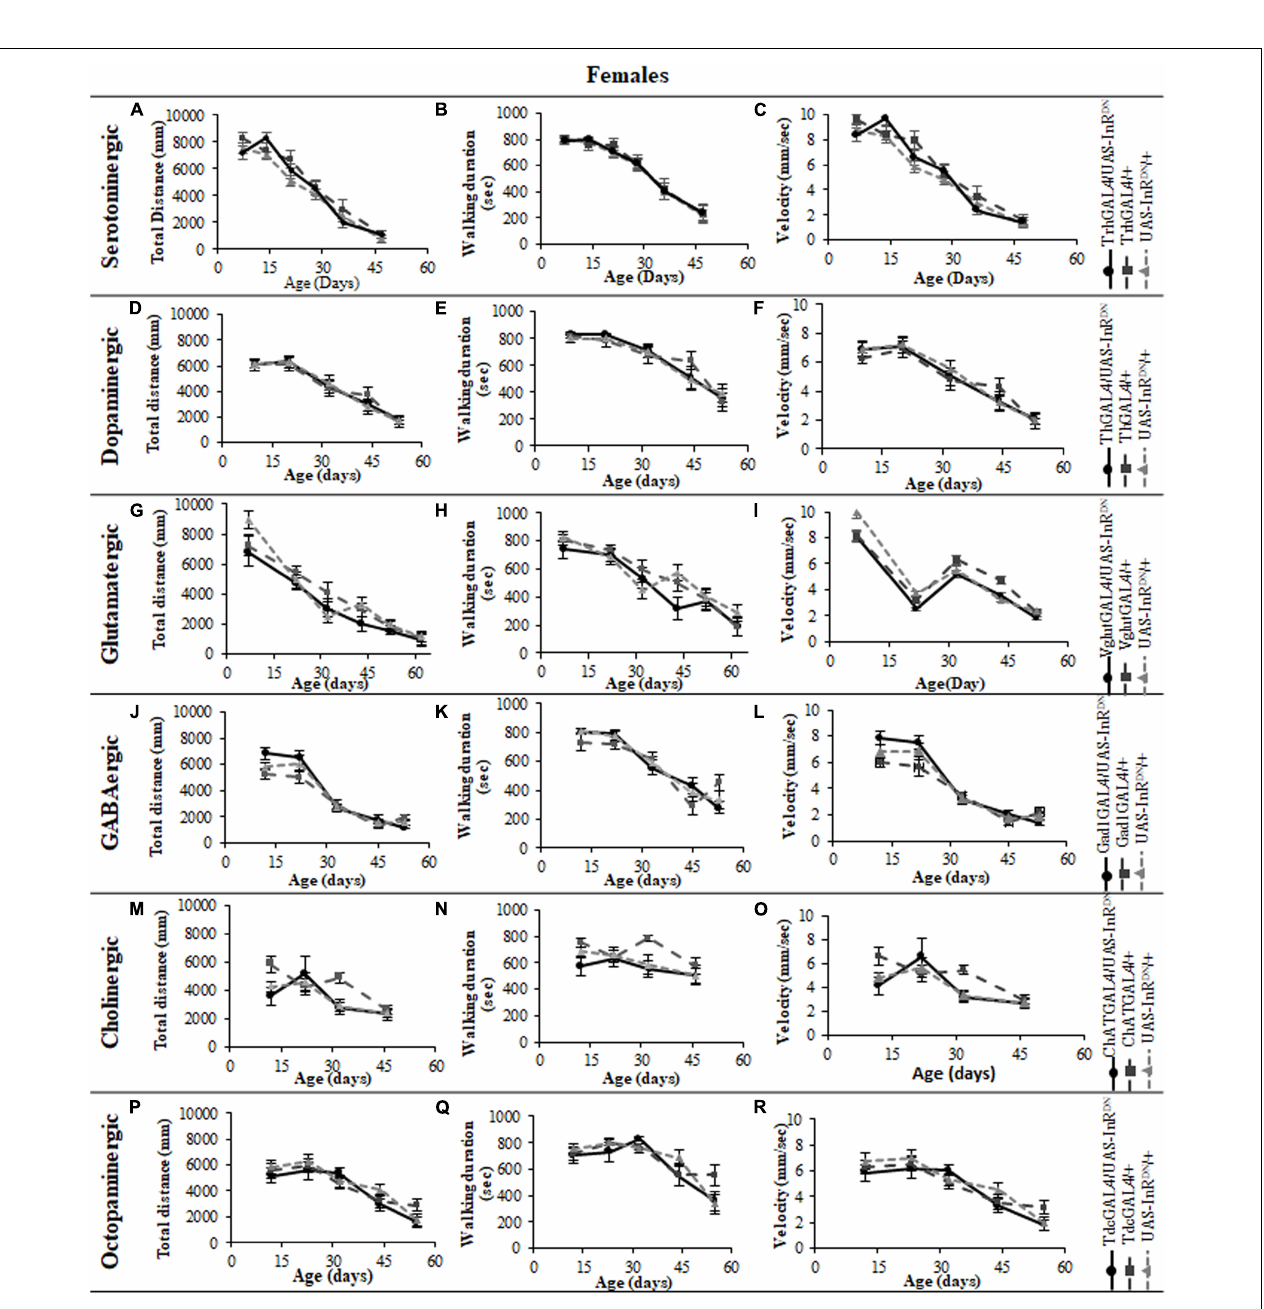
FIGURE 4 | compared to Gad1GAL4/ + and UAS-InR DN / + controls. (L) Mean rotation frequency vs. age of Gad1GAL4/UAS-InR DN flies compared to Gad1GAL4/ + and UAS-InR DN / + controls. (M) Mean duration flies spent in the central zone vs. age of ChATGAL4/UAS-InR DN flies compared to ChATGAL4/ + and UAS-InR DN / + controls. (N) Mean latency to first rotation vs. age of ChATGAL4/UAS-InR DN flies compared to ChATGAL4/ + and UAS-InR DN / + controls. (O) Mean rotation frequency vs. age of ChATGAL4/UAS-InR DN flies compared to ChATGAL4/ + and UAS-InR DN / + controls. (P) Mean duration flies spent in the central zone vs. age of TdcGAL4/UAS-InR DN flies compared to TdcGAL4/ + and UAS-InR DN / + controls. (Q) Mean latency to first rotation vs. age of TdcGAL4/UAS-InR DN flies compared to TdcGAL4/ + and UAS-InR DN / + controls. (R) Mean rotation frequency vs. age of TdcGAL4/UAS-InR DN flies compared to TdcGAL4/ + and UAS-InR DN / + controls.